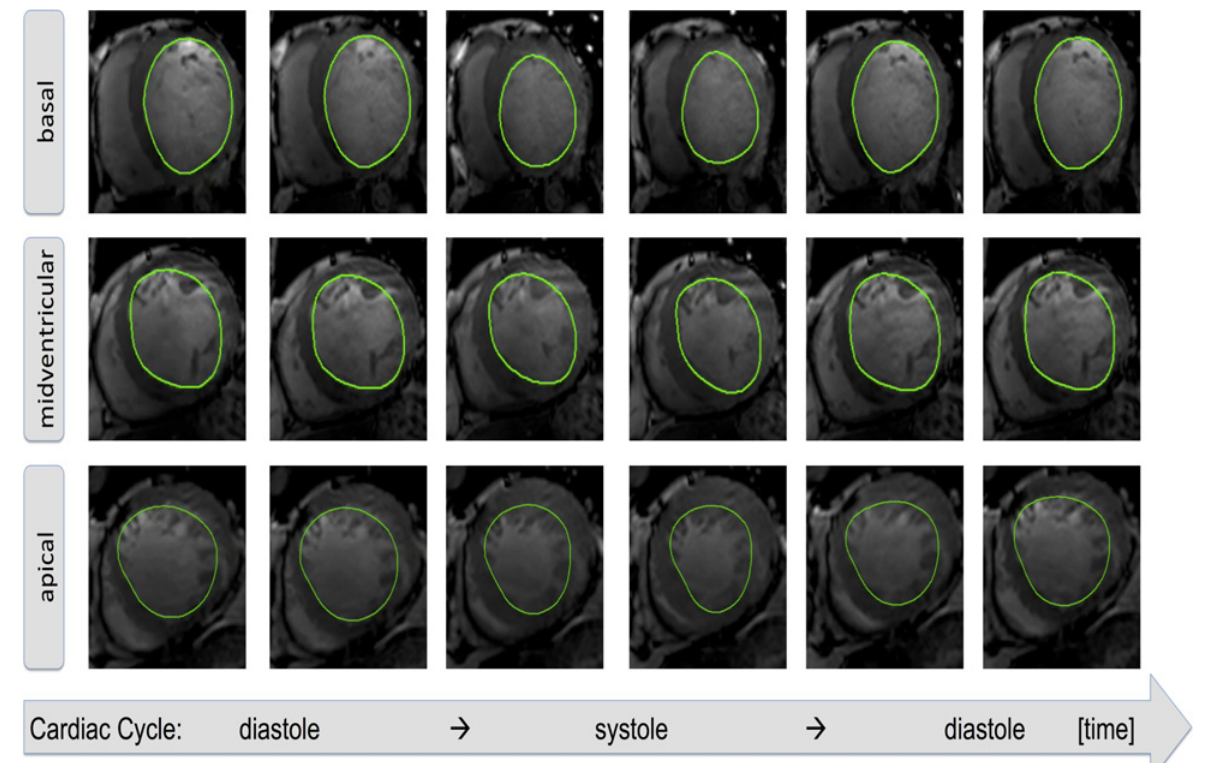
Fig 2. Contour Tracking in Short-Axis Orientation. The figure shows a representative example of the tracking in Short-Axis orientation of an ischemically damaged left ventricle (LV) at basal, midventricular and apical levels. The initial contour is set in end-diastole (left side of the rows) and after application of the feature tracking algorithm the contours (based on the underlying 48 control points) are automatically detected over the cardiac